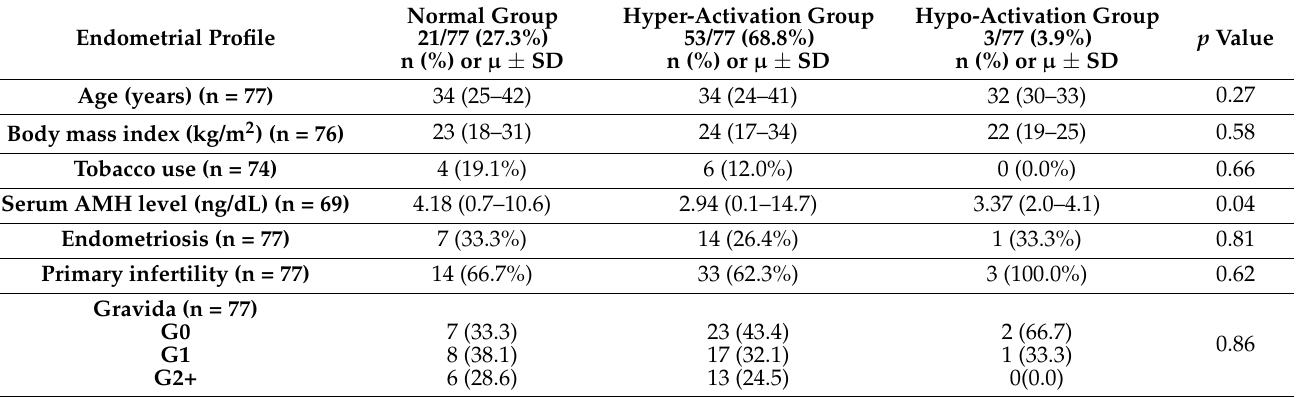
Table 1. The characteristics of the study participants, according to their endometrial